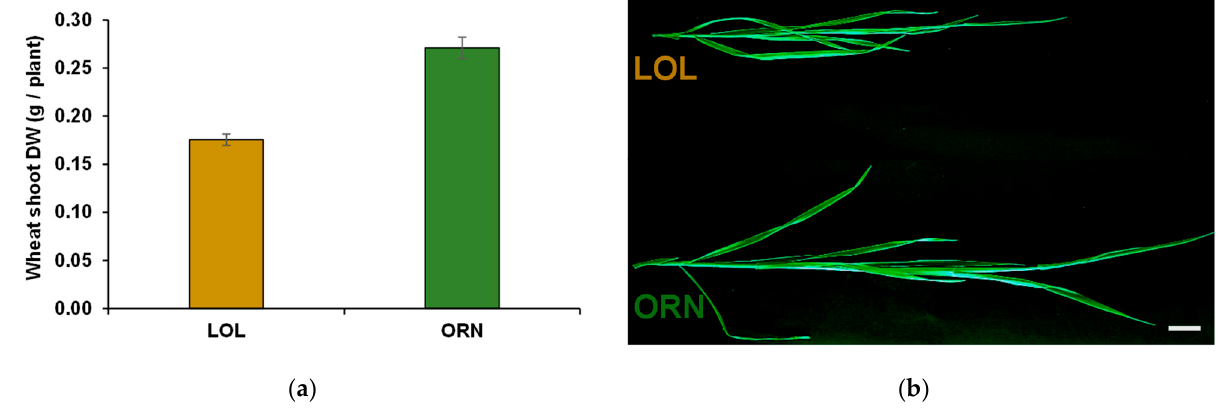
Figure 1. Shoots of wheat plants grown for 3 weeks in acidic soil after the previous development of Lolium rigidum (LOL) or Ornithopus compressus (ORN). ( a ) Growth assessed through shoot dry weight (DW) per plant; ( b ) visual aspect of shoots of wheat grown in each soil treatment. Scale bar = 1